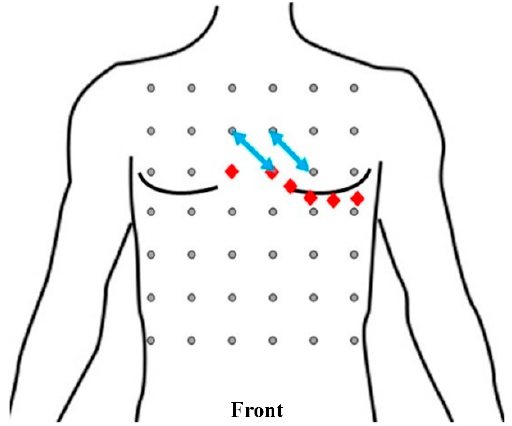
Figure 16. Front view of the positions and orientations of electrode pairs 10 / 17 and 9 / 16 (blue arrows). The red diamonds indicate the electrode locations of precordial leads V1–V6 of the standard 12-lead ECG system.